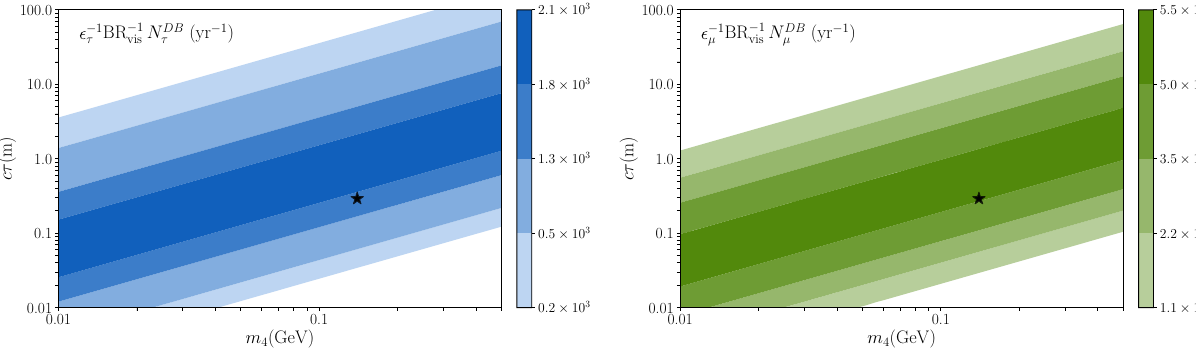
Fig. 1 Expected number of DB events per year at Icecube/DeepCore. The left panel shows the result for ν τ up-scattering into the heavy neu- trino, while the right panel considers ν μ up-scattering. The black star indicates a representative point in the parameter space for the model of